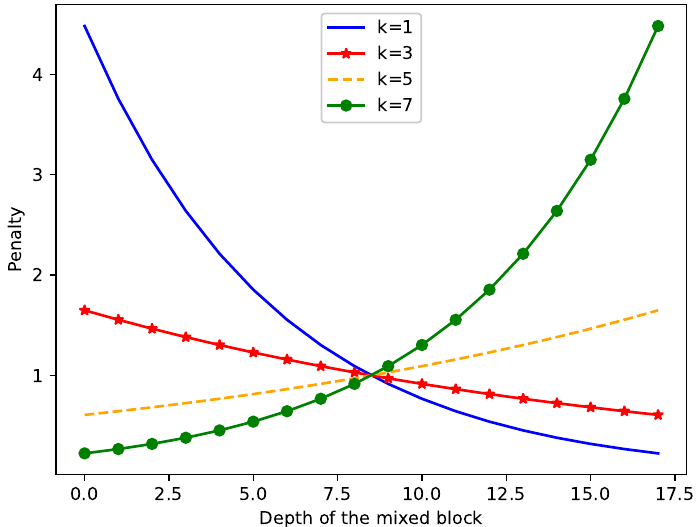
Figure 4. Penalty for a candidate operation set, including convolution and down pooling with a kernel size of 1, 3, 5 and